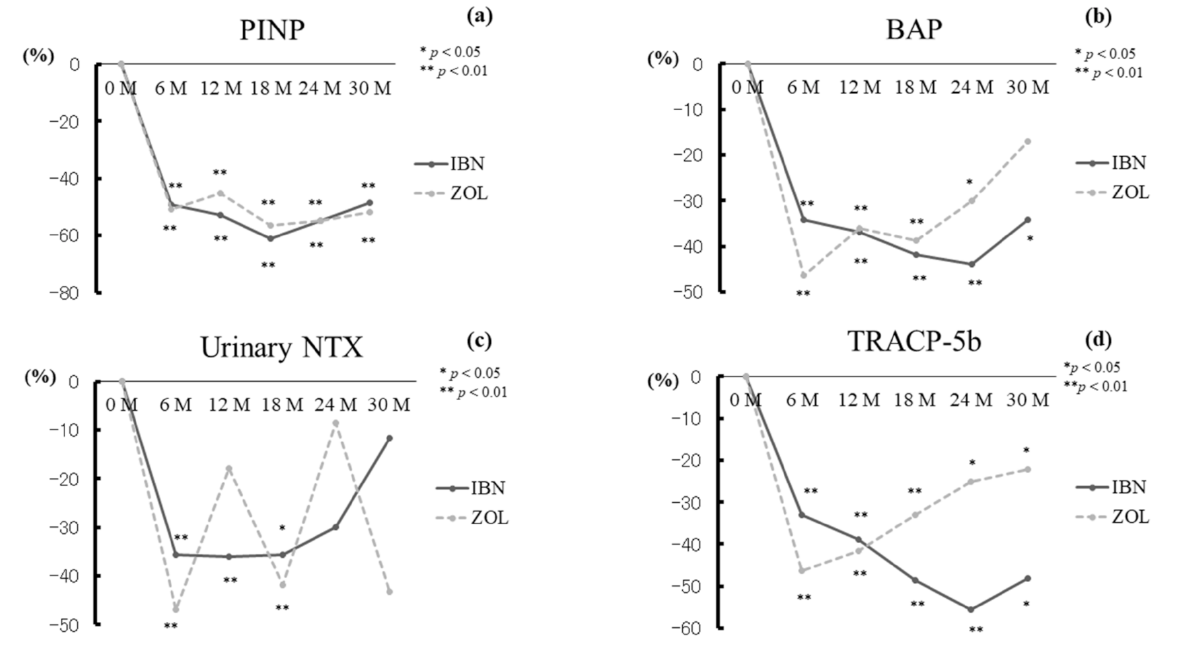
Figure 3. Percentage changes of PINP ( a ), BAP ( b ), urinary NTX ( c ), and TRACP-5b ( d ). All values were significantly decreased from baseline values at every time point in both groups apart from BAP at 30 months in the ZOL group and urinary NTX at 12 months in the ZOL group and at 24 and 30 months in both groups. *: p < 0.05, **: p < 0.01. We observed no significant differences between the groups at any time point for